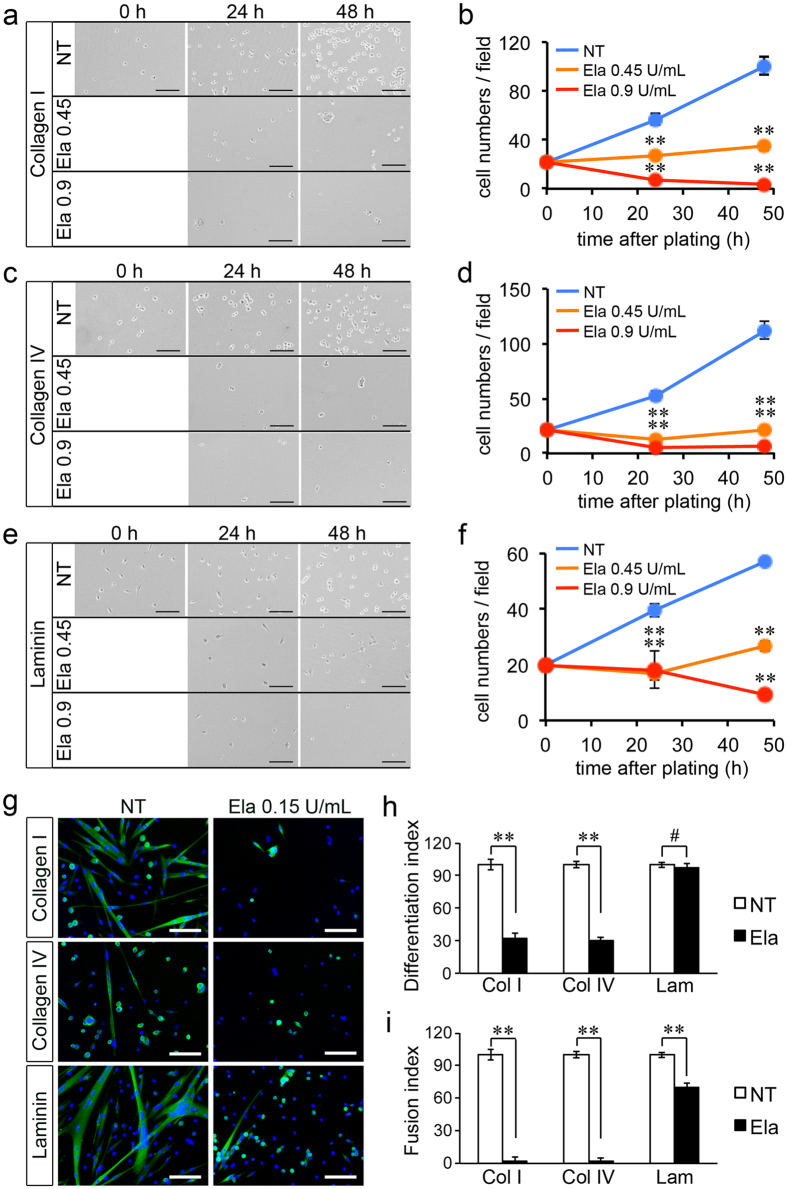
Elastase treatment impairs primary myoblast growth and differentiation rates.(a,c,d) Representative images of primary myoblasts seeded on collagen type I (a), collagen type IV (c) or laminin (e) and either non-treated or treated with elastase (0.45 U/mL and 0.9 U/mL) for 1 and 2 days. (b,d,f) Quantification of (a,c,e), respectively. For quantification, 10 images per experiment across 3 independent experiments (N = 30 images) were scored for cell numbers, averaged and plotted as a function of time. (g) Representative images of primary myoblasts maintained in differentiation medium for three days then immunostained to detect myosin heavy chain (MyHC, green) and DAPI (blue). (h) The differentiation index was calculated as the percentage of MyHC + cells over the total number of DAPI + cells, then for each culture condition (Col I, Col IV and Lam) the differentiation index of non-treated cells was set to 100% and the differentiation index of treated cells expressed as a fraction of 100 in order to average different experiments. Ten images per experiment across 3 independent experiments were analysed (N = 30). (i) The fusion index was calculated as the percentage of MyHC + cells in myotubes over the total number of MyHC + cells, then for each culture condition (Col I, Col IV and Lam) the fusion index of non-treated cells was set to 100% and the fusion index of treated cells expressed as a fraction of 100 in order to average different experiments. Ten images per experiment across 3 independent experiments were analysed (N = 30). Error bars are S.E.M.; **p < 0.01; #p > 0.05. Scale bars are 100 μm.